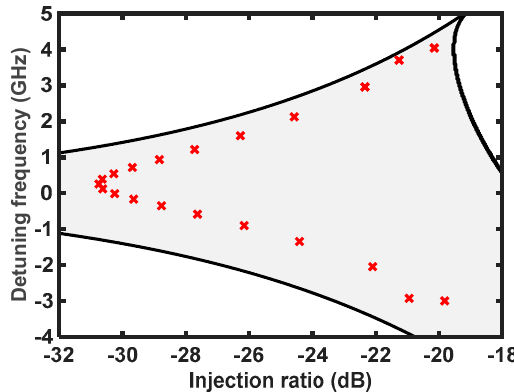
Figure 6. Distribution of 21 elements of an OIL–OPA on the injection ‐ locking map as a function of the detuning frequency and injection ratio. This distribution achieved the Taylor AM distribution and a phase di ff erence of ∆ φ = + 6 ◦ between adjacent elements.